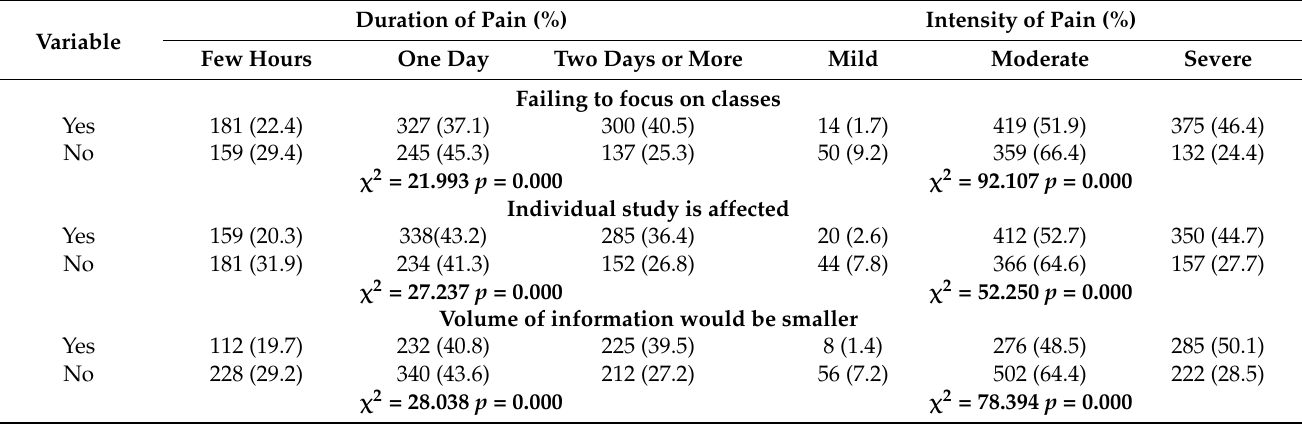
Table 6. The Effect of Dysmenorrhea on University Performance ( n =